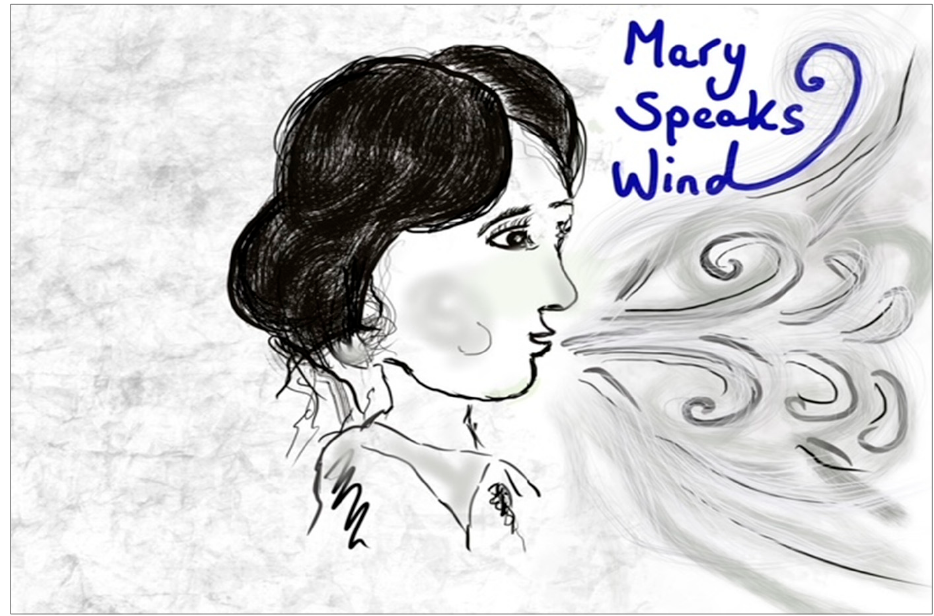
Figure 5. Mary becoming-post-human, she speaks wind, bird (starling), dog and sunlight.